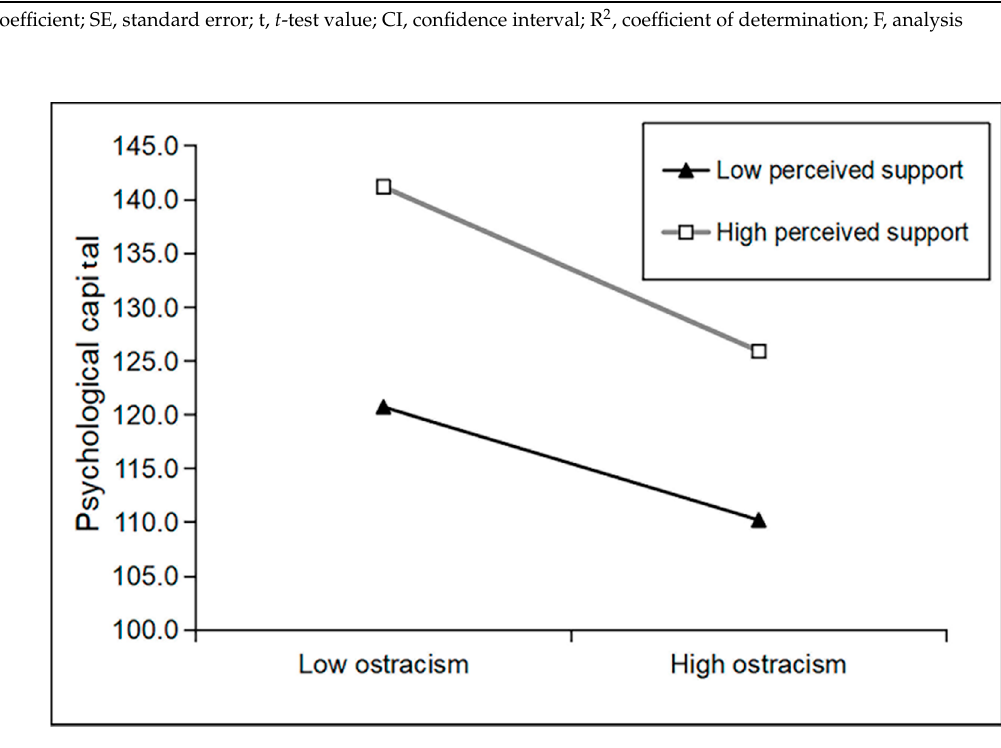
Figure 2. Perceived social support moderates the effect of ostracism on psychological capital.